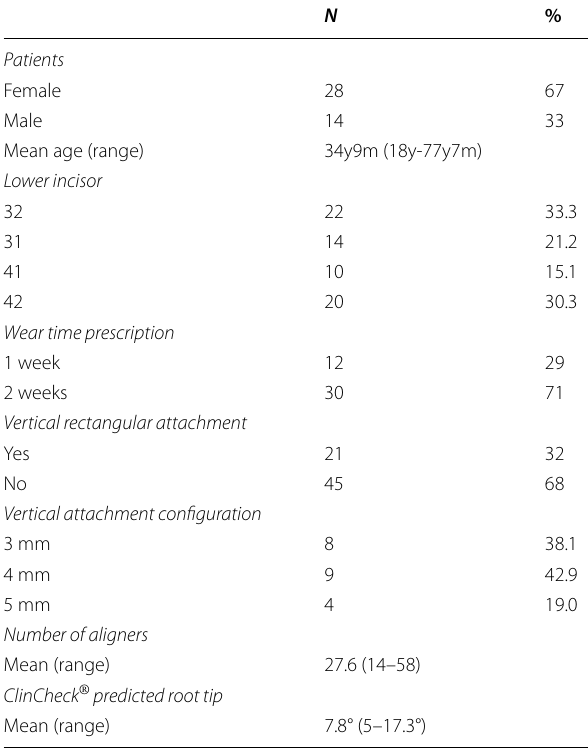
Table 1 Descriptive statistics for the sample investigated